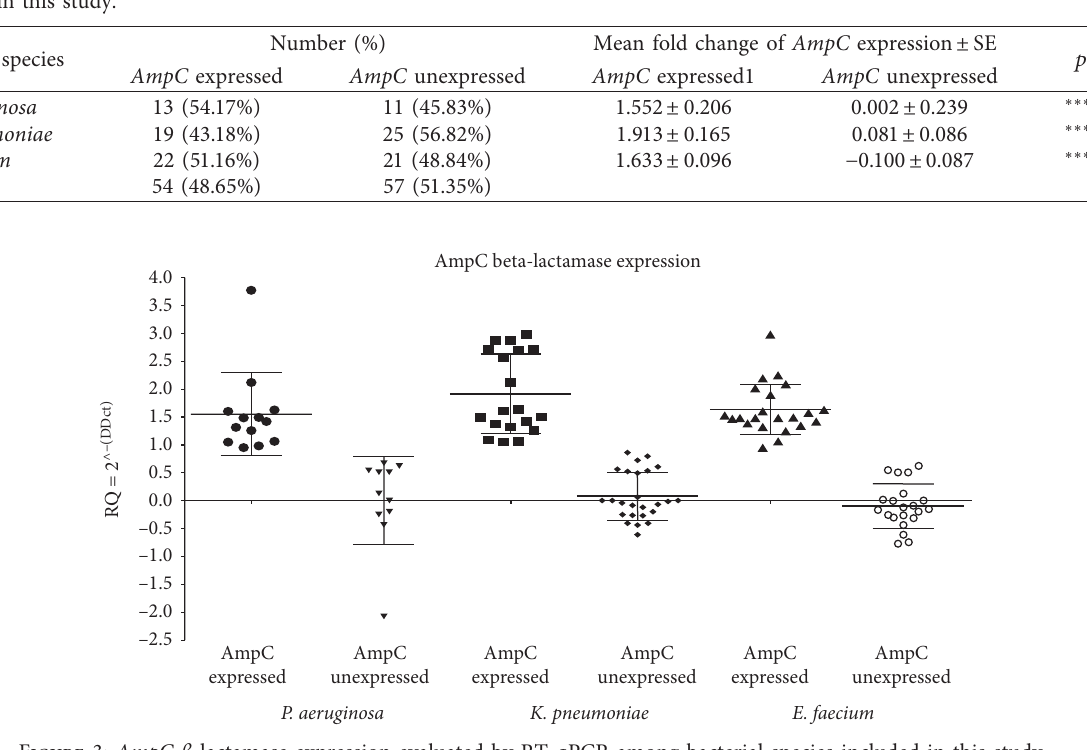
Figure 3: AmpC β -lactamase expression evaluated by RT-qPCR among bacterial species included in this